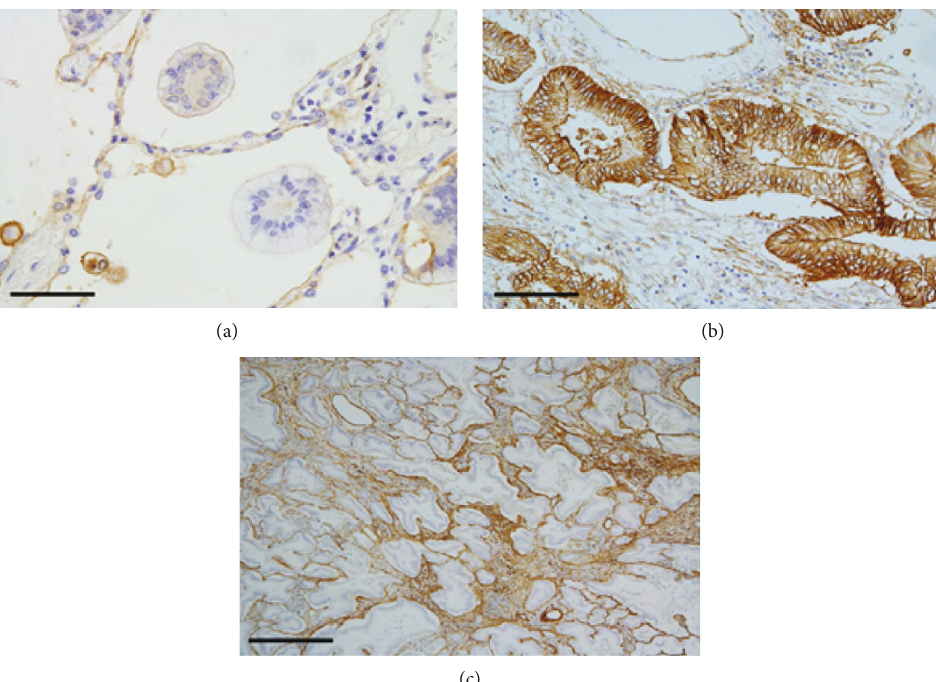
Figure 6: Floating tumor cells (a) and invasive components (b and c) of the left lung tumor. (a) No distinct ANX A2 positivity is visible in the fl oating tumor cells within alveolar spaces. ANX A2 immunostain, scale bar: 100 μ m. (b) Stronger cytoplasmic ANX A2 positivity is observed on the basal side, and positive staining is visible at the cell – cell borders. ANX A2 immunostain, scale bar: 200 μ m. (c) The desmoplastic stroma exhibits positive collagen IV staining, particularly around the tumor cells. Collagen IV immunostain, scale bar: 1mm.